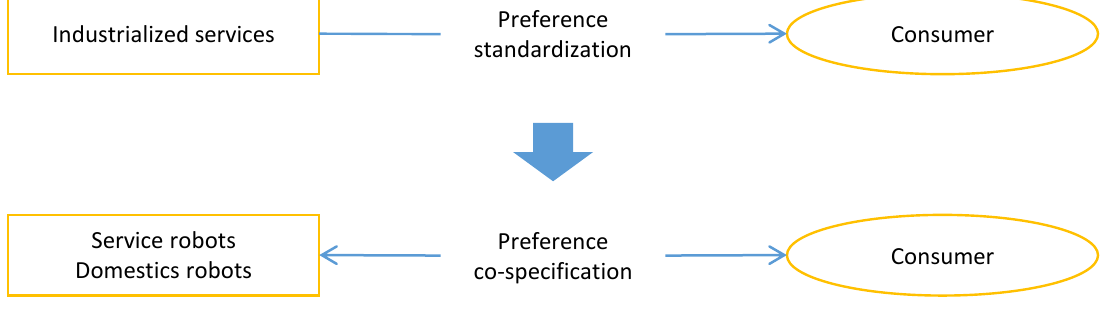
Figure 2. From traditional to AI-based service